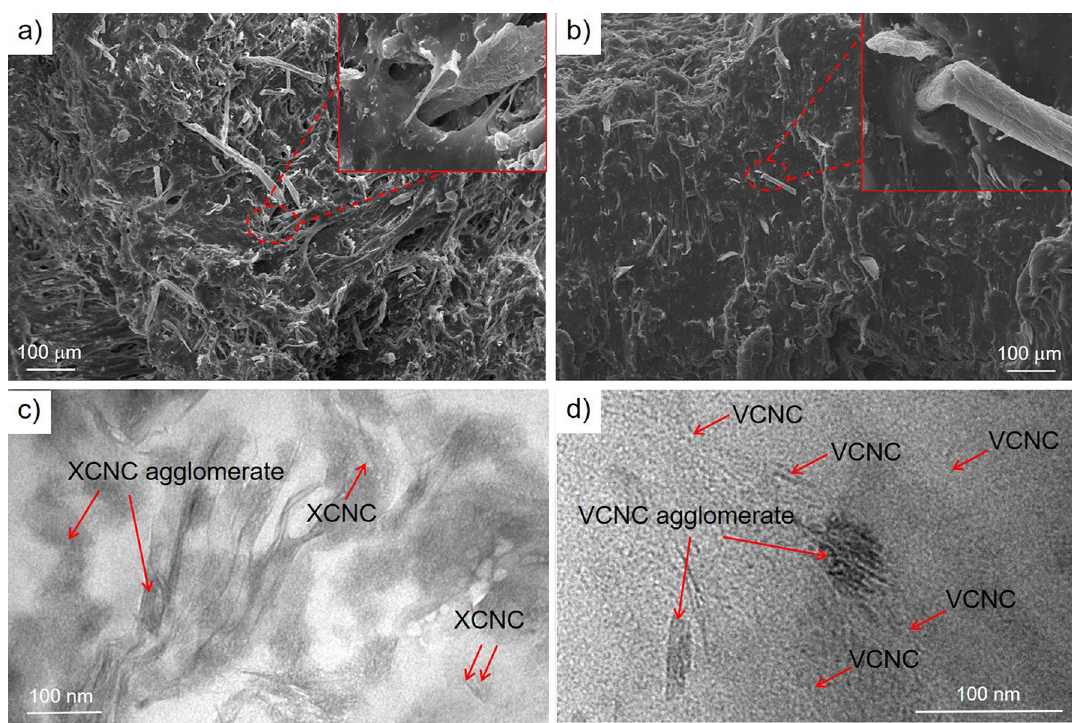
Figure 10. SEM and TEM images of the biocomposites; ( a , c ) the NR/XCNC3 and ( b , d ) the